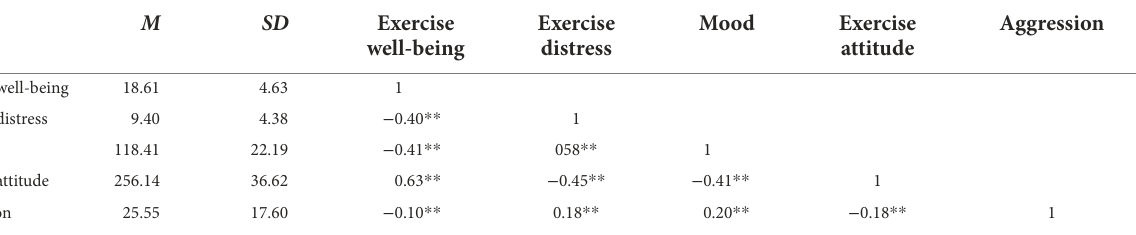
TABLE 1 Descriptive statistics of variables.